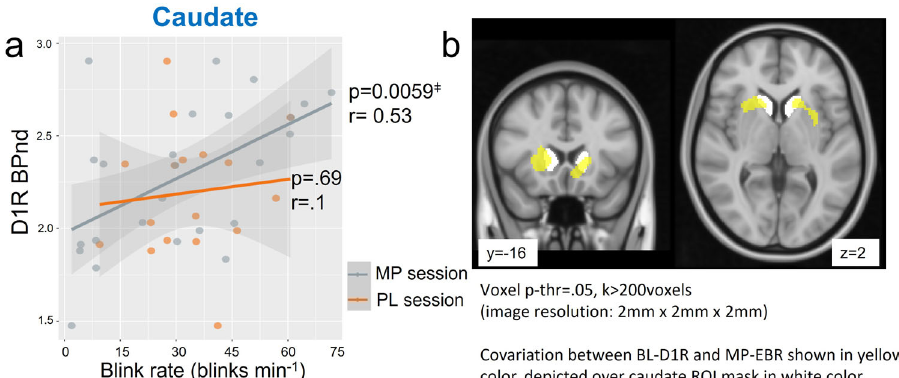
Fig. 3 Caudate D1R BPnd and EBR relationship. a Regression plot for D1R availability (BPnd) measures obtained at baseline (BL-D1R) in the caudate ROI with the eye blink rates measures obtained after placebo (PL-EBR) and after MP (MP-EBR), shaded area indicates 95% Con fi dence Interval (CI), each points represents a value from each participant. Orange color indicates PL session, and gray color indicates MP session. b Voxel-wise regression (uncorrected; voxel p -threshold = 0.05, k > 200 voxels) showing the cluster after covariance analysis between BL-D1R and MP-EBR in yellow, depicted over the caudate ROI mask shown in white. Participants with higher baseline D1R availability in caudate had higher blink rates with MP (n(MP) = 25, n(PL) = 17). Cluster did not survive FDR correction.